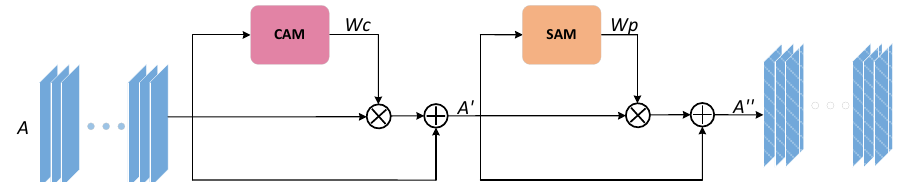
Figure 3. The improved architecture of the attention mechanism block (AMB) module.